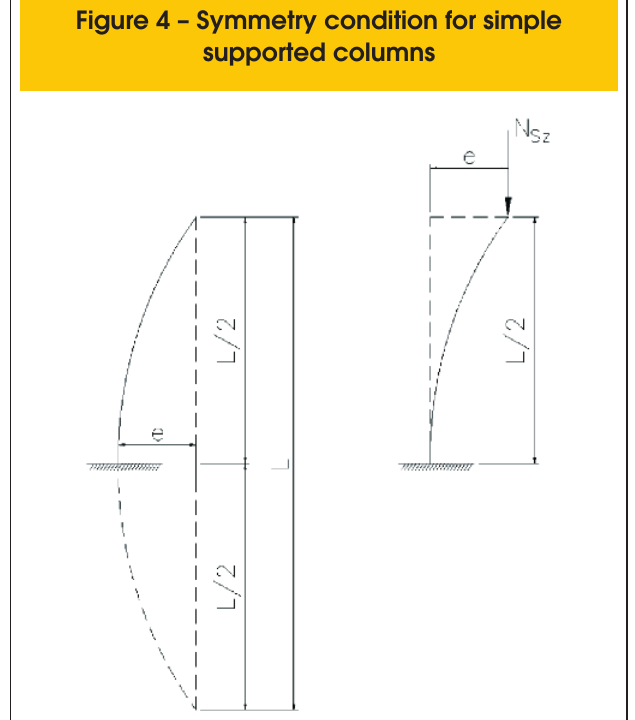
Figure 4 – Symmetry condition for simple supported